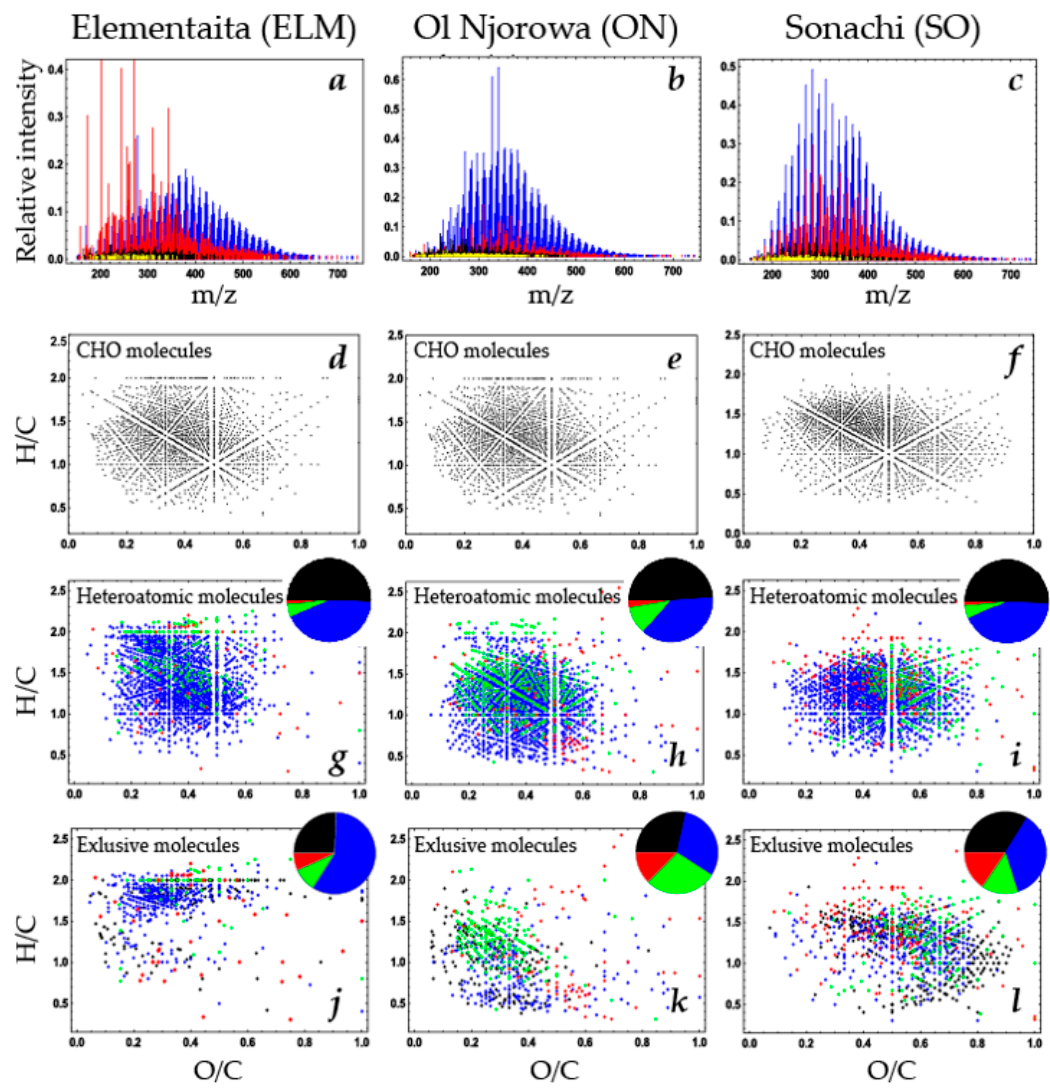
Figure 2. FT-ICR-MS spectra of SPE-DOM, molecular footprints, and associated van Krevelen diagrams for hot springs (ELM, ON) and Lake Sonachi (SO). Colors in the spectra (panels a–c ) indicate the CRAM-like (blue), CA (yellow), aromatic (black) and aliphatics (red) molecular categories. For better visualization, the van Krevelen diagrams of CHO molecules ( d–f ) are separate from the van Krevelen diagrams of heteroatomic molecules. Pie plots in the van Krevelen diagrams ( g–l ) indicate the frequency of the CHO (black), CHNO (blue), CHOS (green), and CHNOS (red)